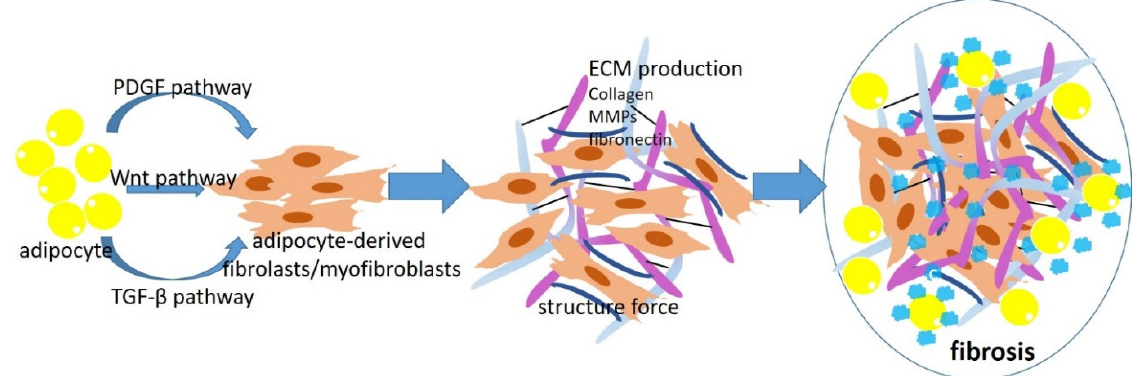
Figure 1. The mechanism underlying adipocyte-derived myofibroblasts/fibroblasts in obesity-associated fibrosis. During obesity development, adipocytes acquire a fibroblast-like transcriptional signature through PDGF, WNT, and TGF- β pathways. Adipocyte-derived fibroblasts/myofibroblasts deposit significant amounts of ECM and ECM-related enzymes, including collagen, fibronectin, and MMPs. The fibroblasts/myofibroblasts also “tug and pull” the ECM network around them, which further enhances the ECM alignment and fibrosis.